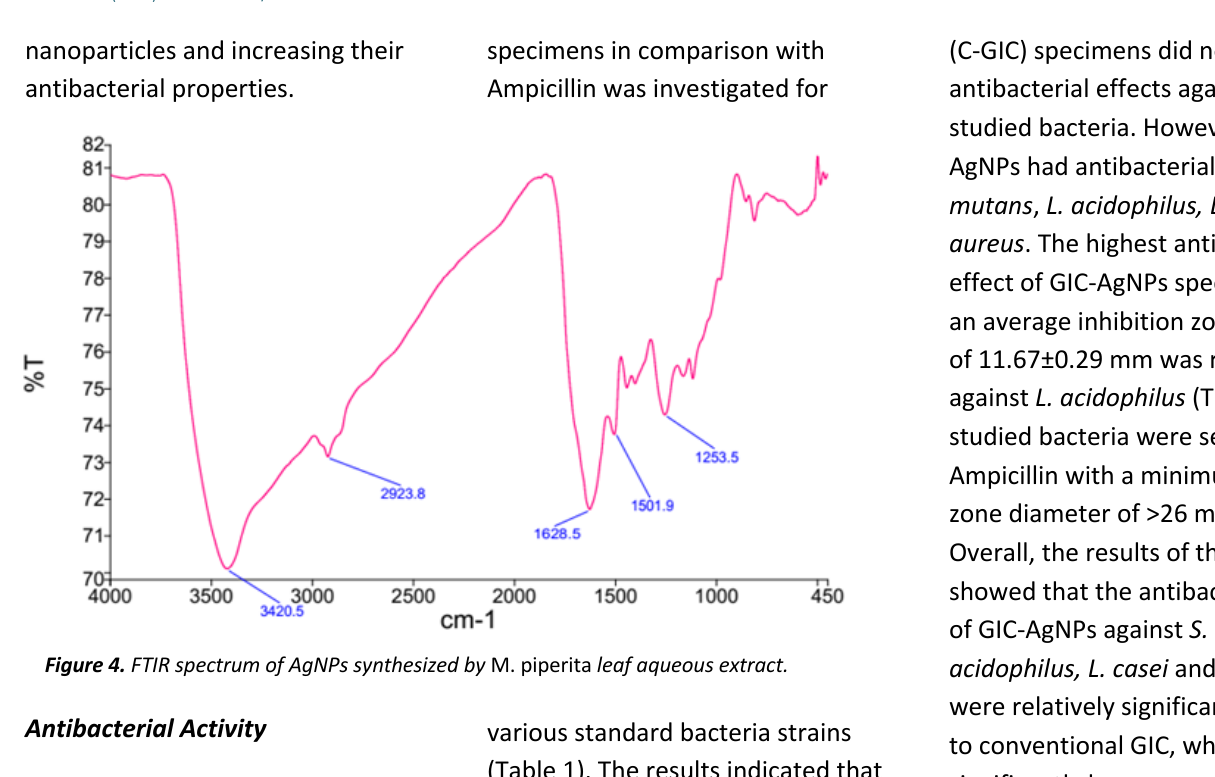
Table 1: Antimicrobial activity of Glass Ionomer Cement (GIC), GIC- AgNPs, and Ampicillin specimens against various standard bacteria